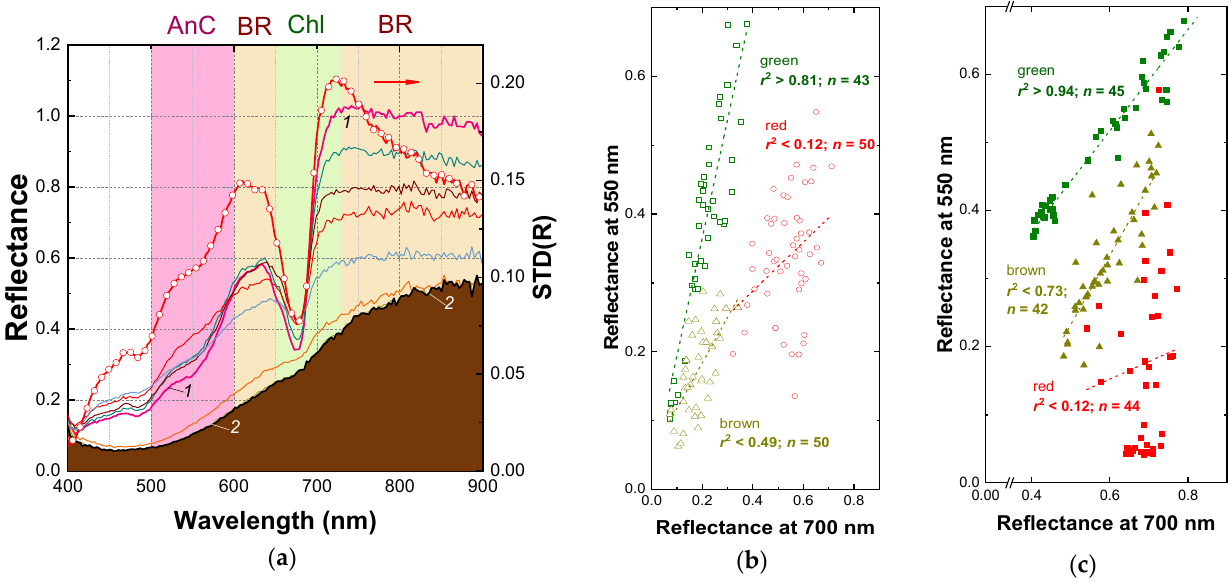
Figure 3. Hyperspectral reflectance spectra ( a ) taken with the SPECIM IQ imaging hyperspectrometer from the regions of a representative apple fruit (cv. Ligol) featuring a different degree of sunscald-induced browning ranging from visually unaffected (curve 1 ) to severely affected (curve 2 ) (left scale) and their standard deviation, STD (symbols, right scale). Panels ( b , c ): relationships between reflectance coefficients in the green, R 550 and in the red edge, R 700 spectral regions in healthy green fruits (squares), red fruits (circles), and fruits affected by browning (triangles) plotted for the hyperspectral data ( b ) extracted from the HRI images and ( c ) for the “point-type” reflectance measurements. In panel ( a ), the spectral regions governed by chlorophyll (Chl), anthocyanin (AnC), and melanin-like brown pigment absorption (BR) are shown [12,30] .